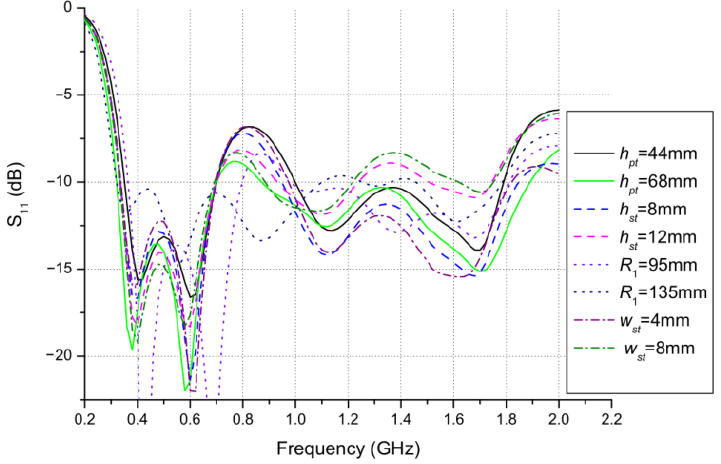
Figure A2. Simulated reflection coefficients regarding adjustments of dimensional